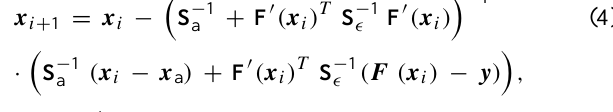
Fig. 2. Simulated radiance spectra for the GLORIA instrument op- erating in “dynamics” mode. Calculations are based on mid-latitude atmospheric conditions (Remedios et al., 2007) and 12km tangent altitude. The black curve indicates total radiance. The other curves indicate radiance for single emitter atmospheres (see legend). The black arrow indicates the O 3 line used for the